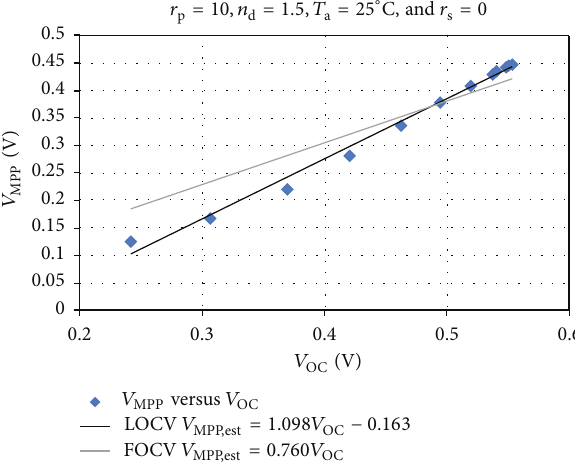
Figure 8: Computed 𝑉 = 25 ∘ C, 𝑛 𝑇 a lines corresponding to the FOCV and LOCV methods are also